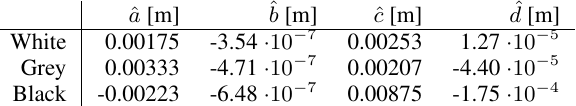
Table 3. Estimated coefficients for the three different surface types. These values are subsequently used in the estimation of per-point uncertainty in ranging direction.